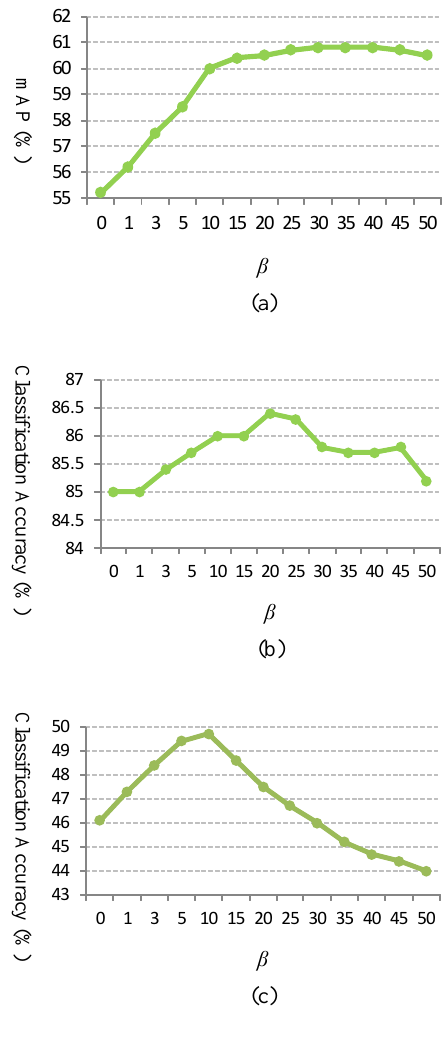
Figure 6. The recognition performance (shown on the Y-axis) w.r.t. different values of parameter β (shown on the X-axis) for GPMK: ( a ) Hollywood2; ( b ) Youtube; ( c )